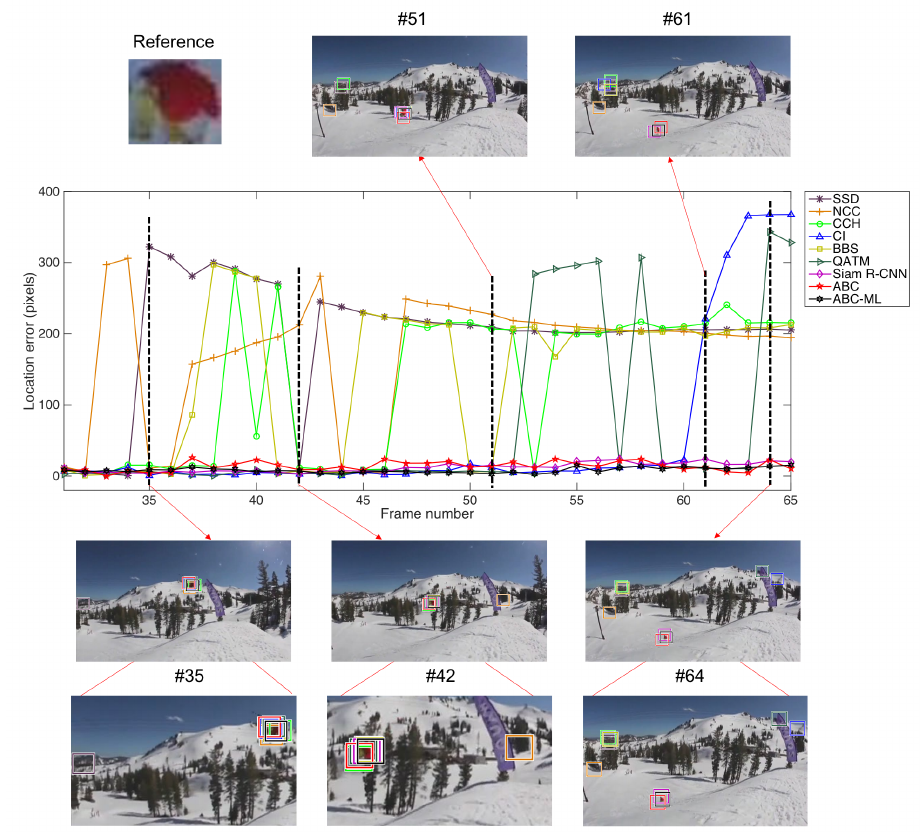
Figure 13. The matching performance of ABC-ML in Skiing